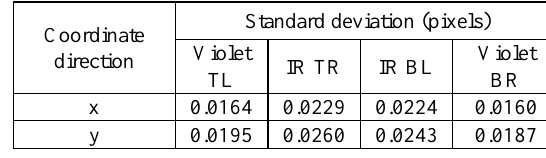
Table 1. Image measurement standard deviations for each of the